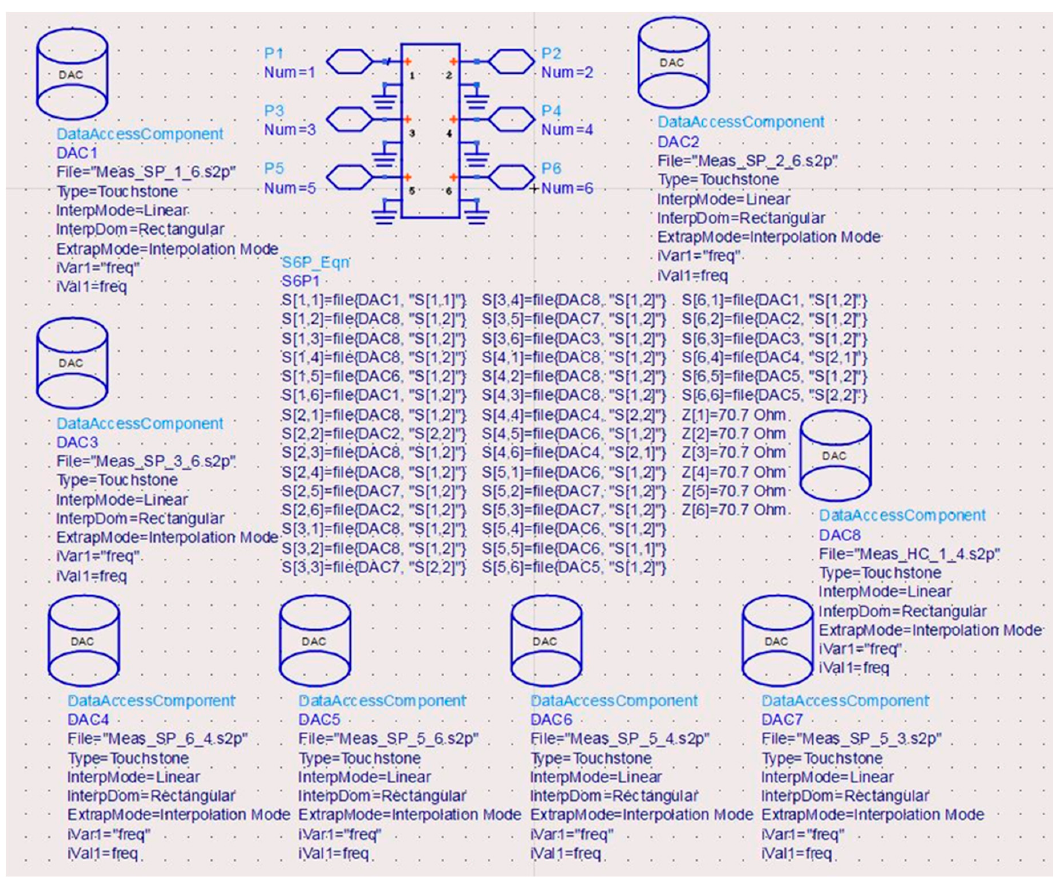
Figure 33. Advanced design system (ADS) multi (six)-port circuit model based on S-parameter measurements.